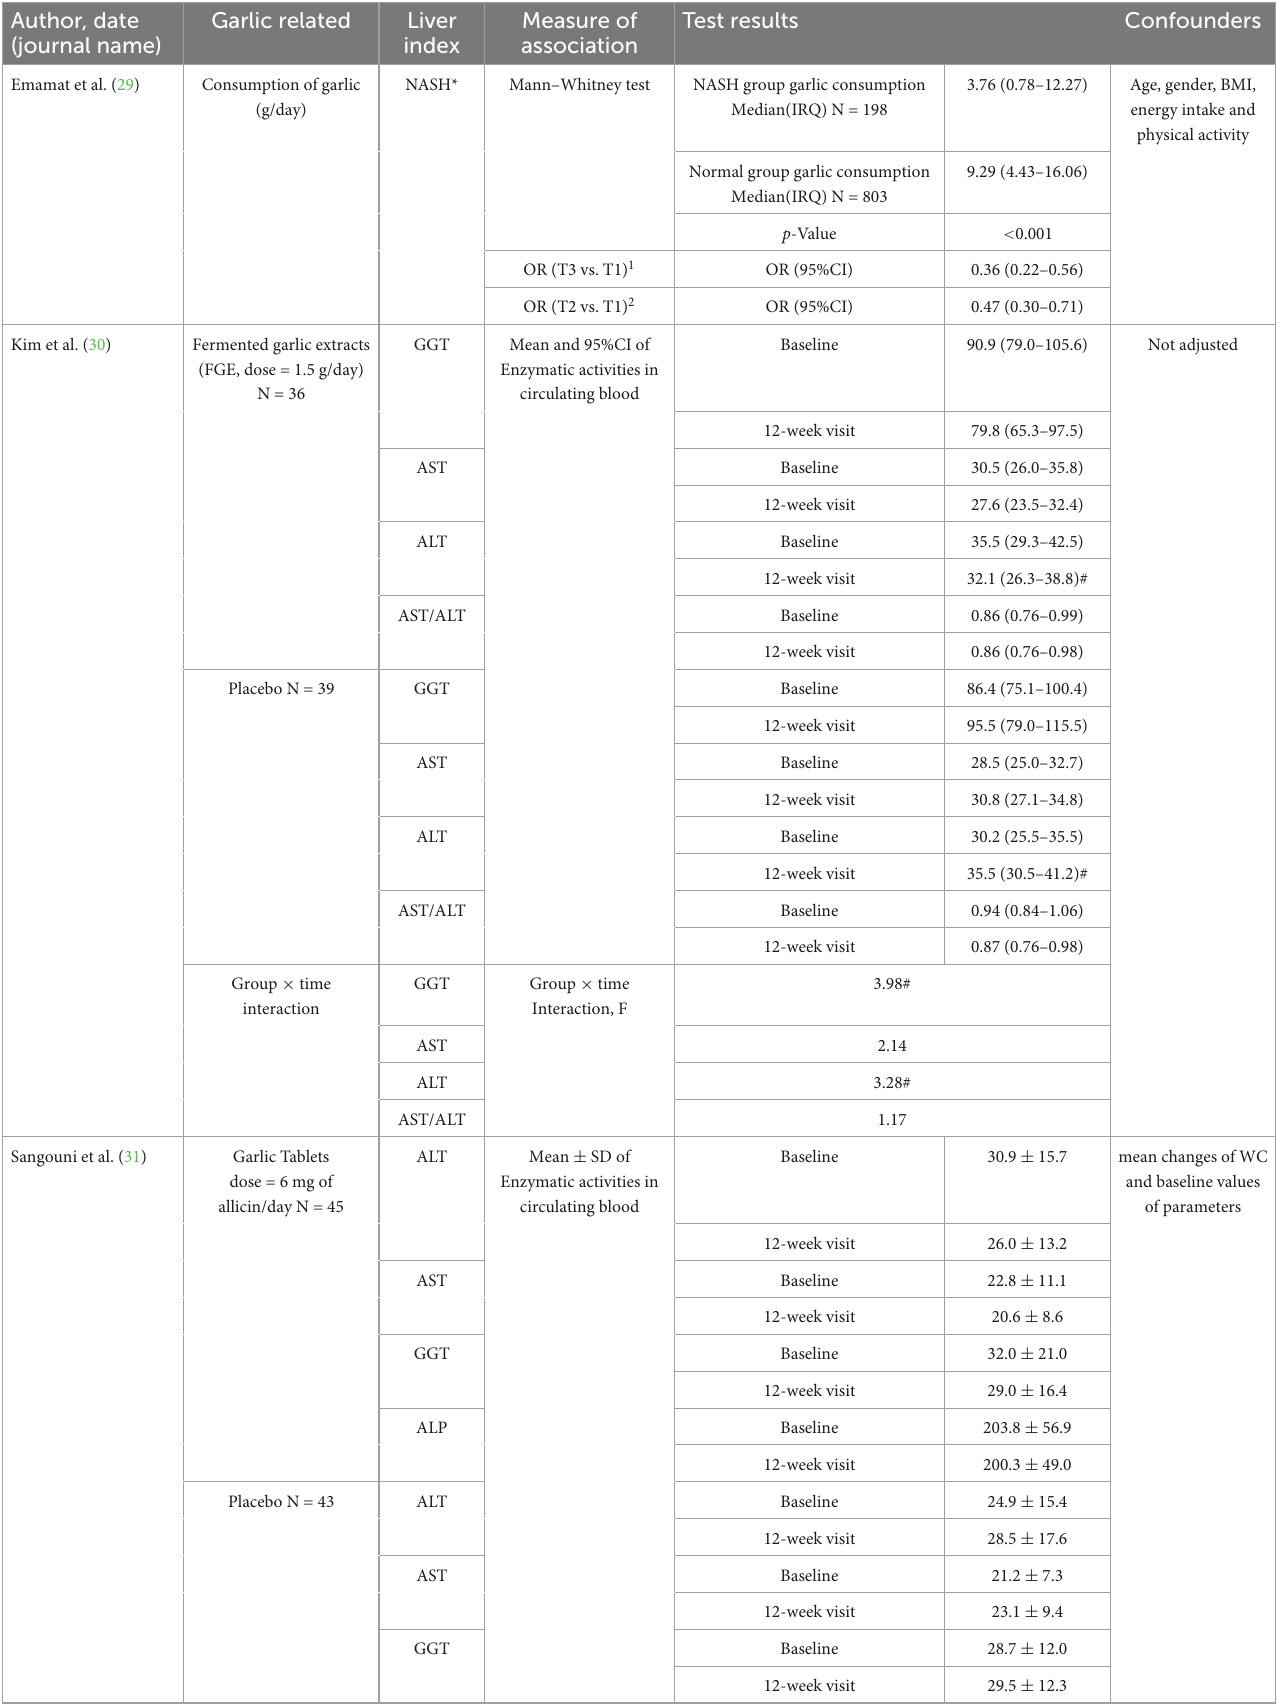
TABLE 2 Qualitative analysis showing the association of garlic and NASH related